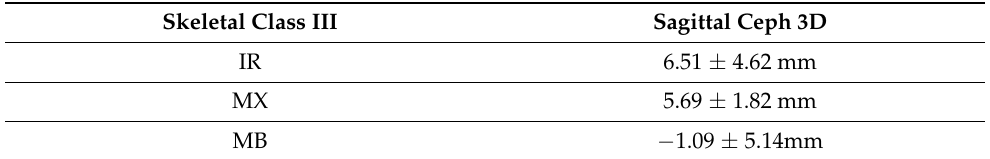
Table 6. Results obtained for Skeletal Class I following analysis employing the Sagittal Ceph 3D